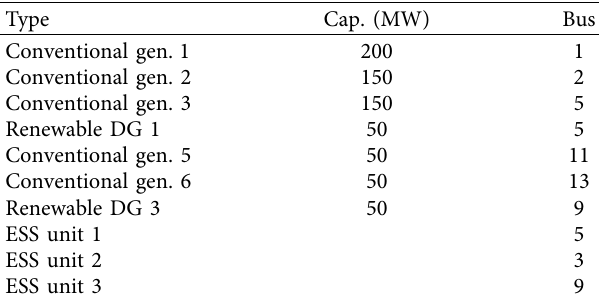
Table 2: Details of IEEE 30-bus test